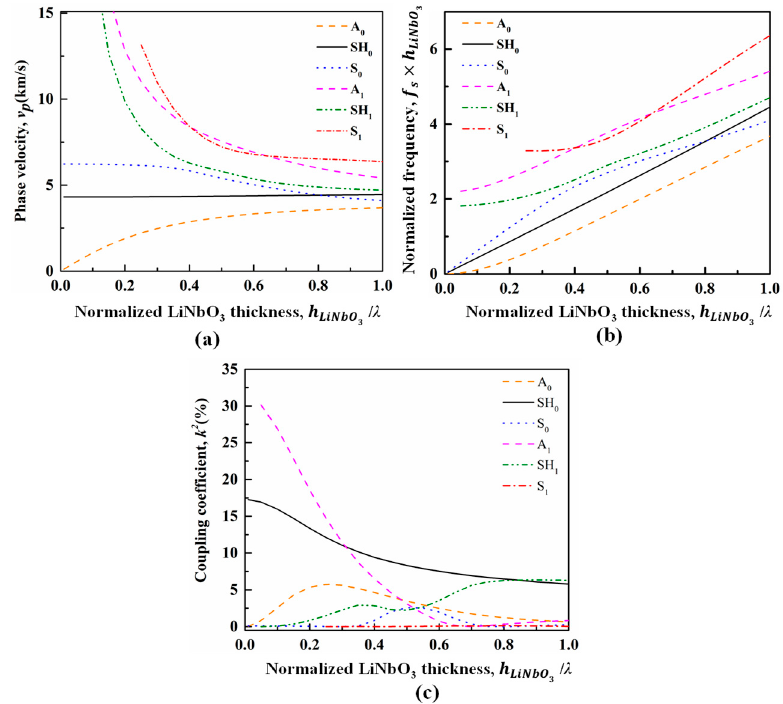
Figure 2. Calculated ( a ) dispersive phase velocities, ( b ) f- β dispersion curve, and ( c ) dispersive coupling coefficients of the first six plate modes in the Z-cut LiNbO 3 membrane.